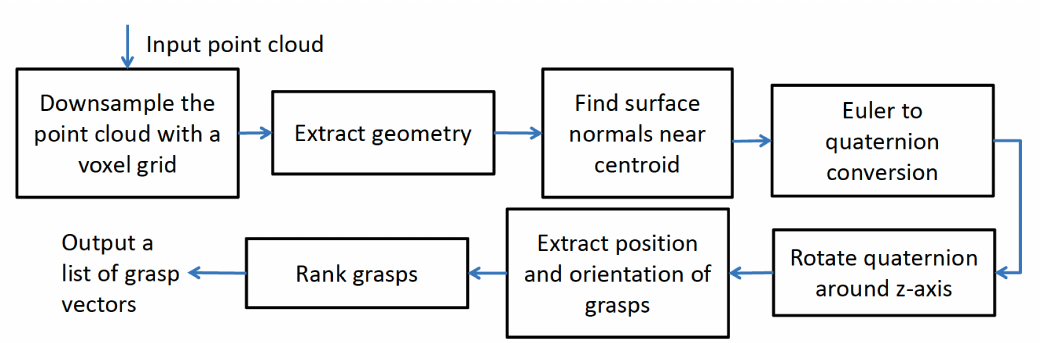
Figure 7. CNA logic flow.